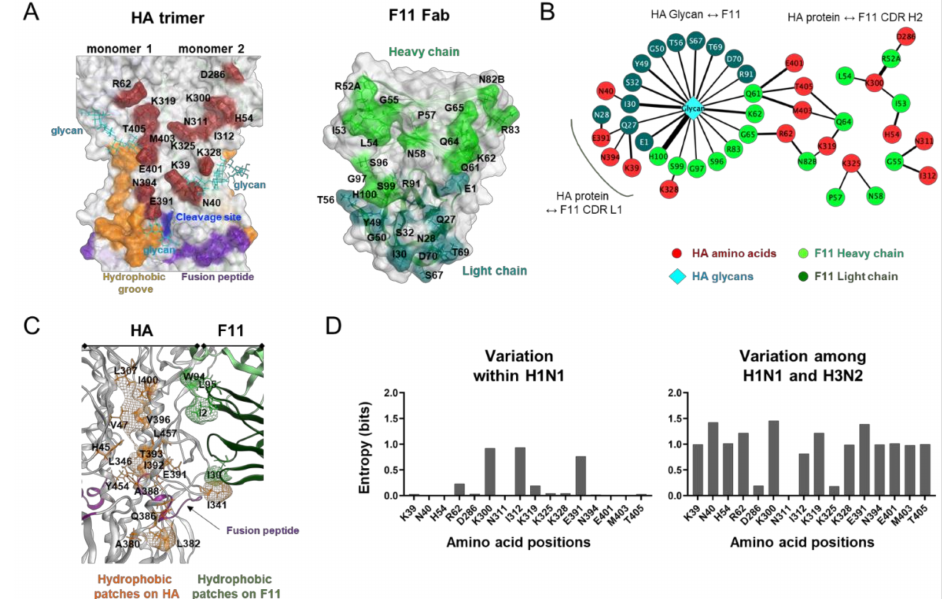
Figure 3. Characterization of molecular interactions between the HA trimer ectodomain and F11 Fab fragment. HA-F11 complex structures collected at every 1 ns during 180 to 200 ns after MD simulations of the top-2 binding mode were used to search for the sites supporting molecular interactions between HA and the F11 antibody using the Contact Analysis application of MOE. ( A ) Visualization of contact sites in the HA trimer (left, wine red residues) and F11 Fab variable region (right, light green and blue green). ( B ) Interaction networks between HA and F11 Fab variable regions. Non-covalent interactions detected during MD simulation were visualized using Cytoscape software version 3.8.2 [34] as described previously [33]. ( C ) Distribution of hydrophobic patches in the binding interface of HA and F11. Hydrophobic patches with a minimum area of 50 Å 2 for protein-protein interactions were estimated using the Protein Patch Analyzer tool in MOE as described previously [31]. ( D ) Variation of individual amino acid residues forming noncovalent interactions during MD simulation. Amino acid sequences of the HA protein of the influenza A virus H1 ( n = 36,564) and H3 ( n = 53,989) were obtained from the GISAID database [42]. Shannon entropy [43] was calculated for individual contact sites detected during MD simulation as described previously